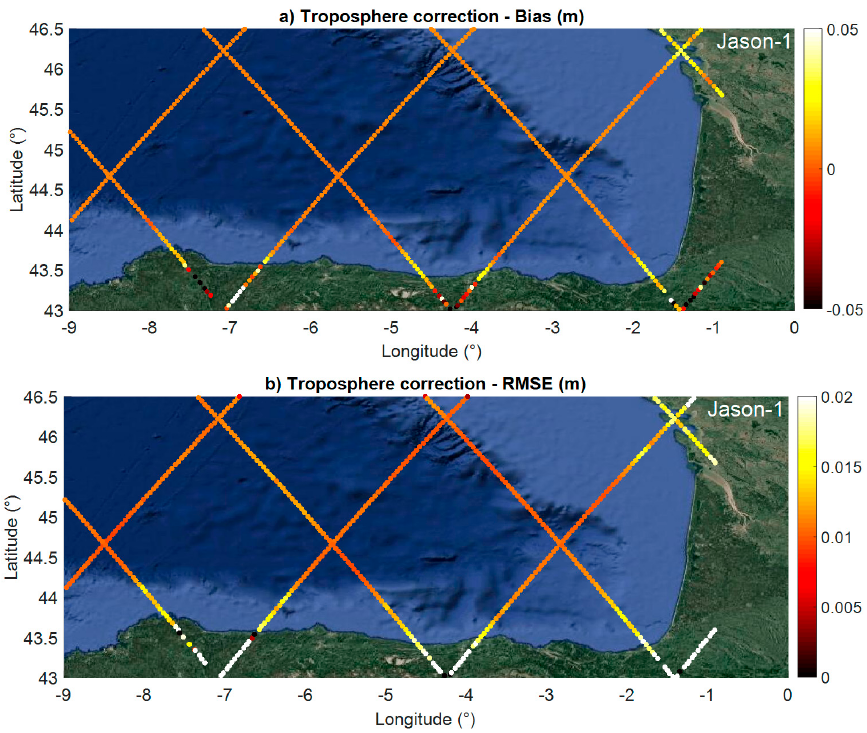
Figure 8. Comparison between wet troposphere corrections from radiometer measurements and the CMWF model for Jason-1b ( a ) Bias and ( b ) RMSE.